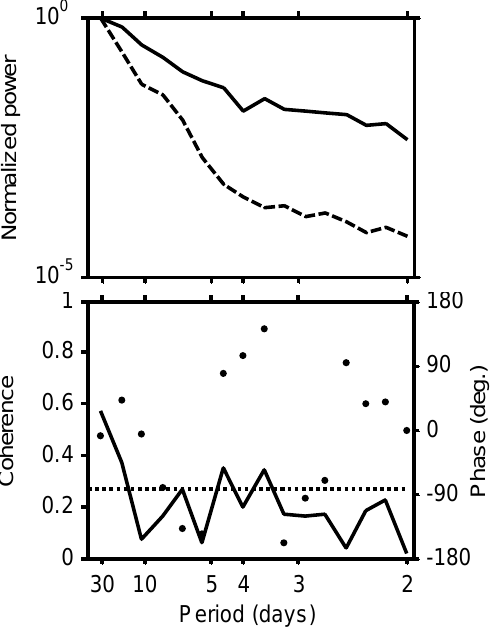
Fig. 10. Spectral analysis for time sequences of the stationary plan- etary wave 1 amplitude at 10hPa, 55–60 ◦ N and the Eureka merid- ional semidiurnal tide amplitude at 88km during the 120-day win- ter interval of 2006/2007. The two time sequences are shown with purple and black lines in Fig. 2b and the correlation coefficient be- tween them is 0.66 (as included in Fig. 7e). Otherwise details are as in Fig.